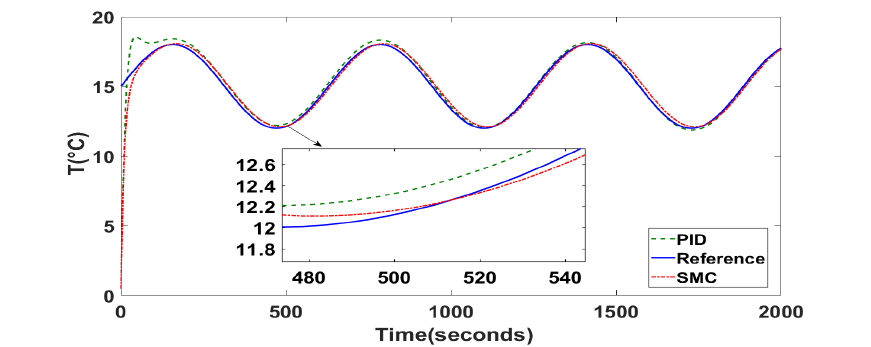
Figure 7. Tracking result of PID and SMC for Zone 2 sine wave reference.